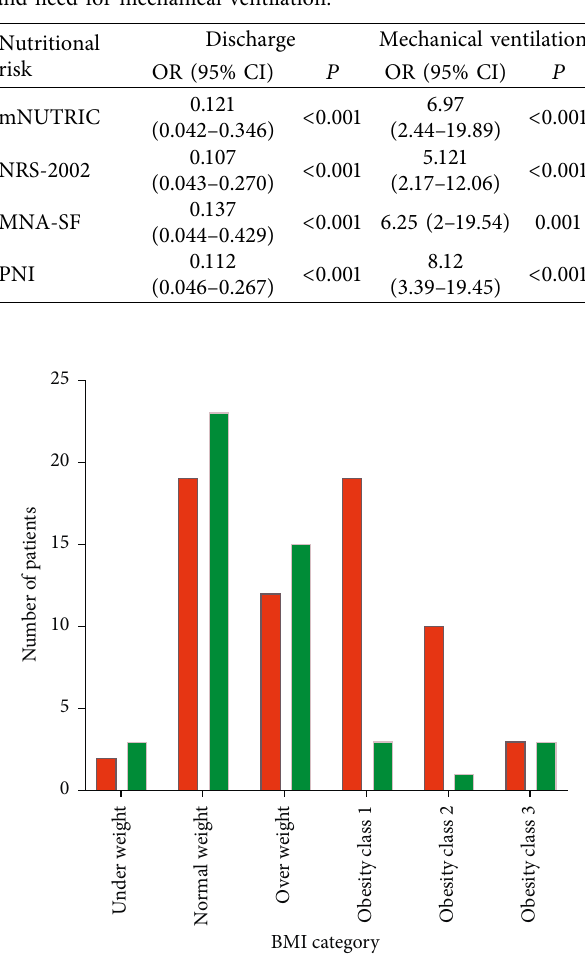
Table 1: Laboratory test comparison between survival and non- survival